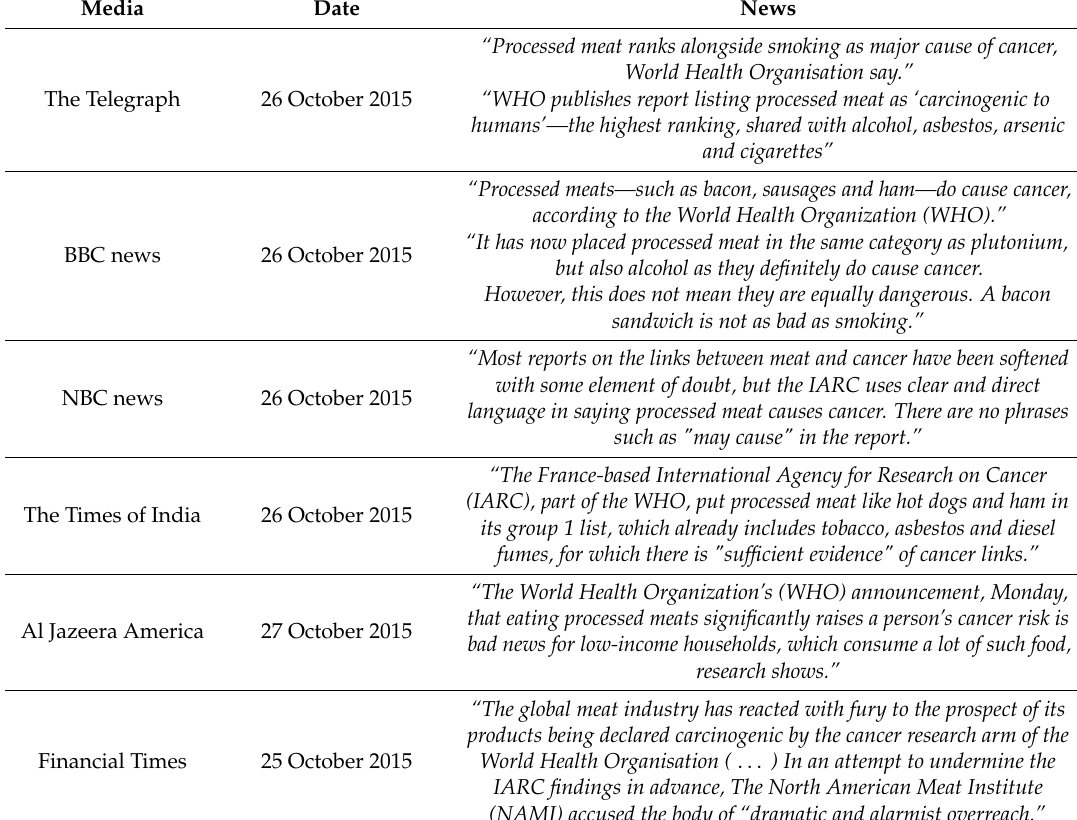
Table 1. Clippings from international media press around October 26, 2015 regarding the WHO announcement about the carcinogenicity of red and processed